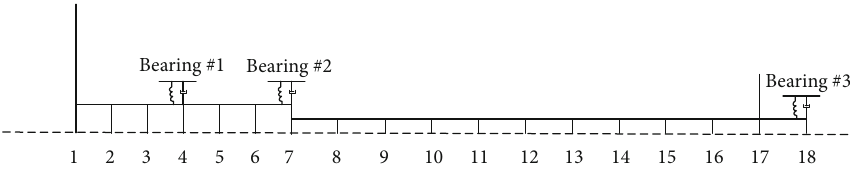
Figure 3: Finite element model of a low-pressure rotor.